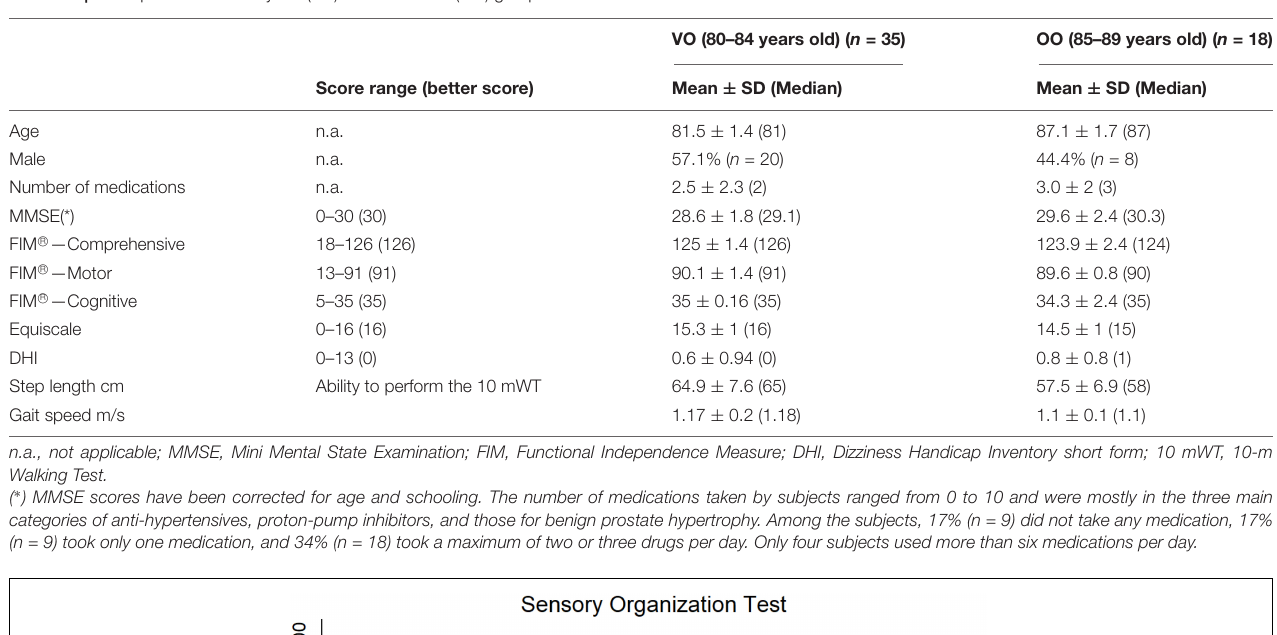
TABLE 2 | Descriptive data on very old (VO) and oldest old (OO) groups.